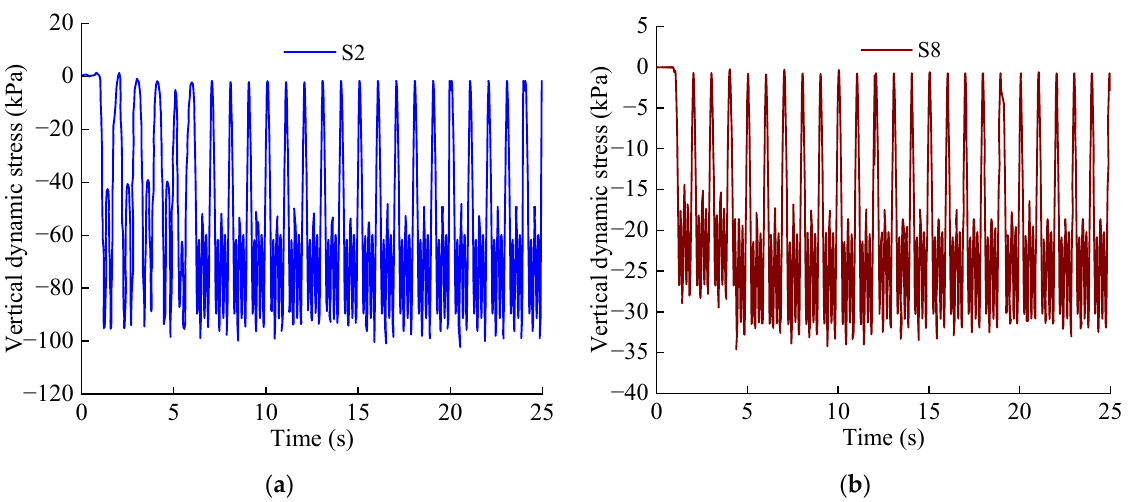
Figure 7. Time–history curve of vertical dynamic stress: ( a ) Measuring point S2; ( b ) Measuring point S8.